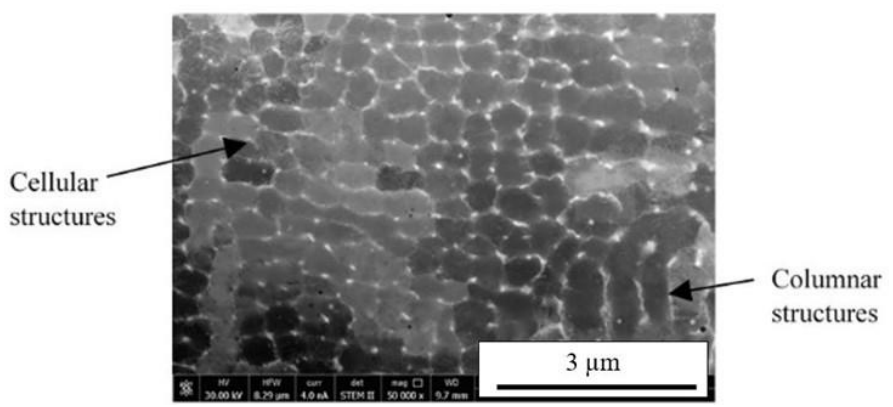
Figure 7. STEM HAADF image showing overview of TEM foil.